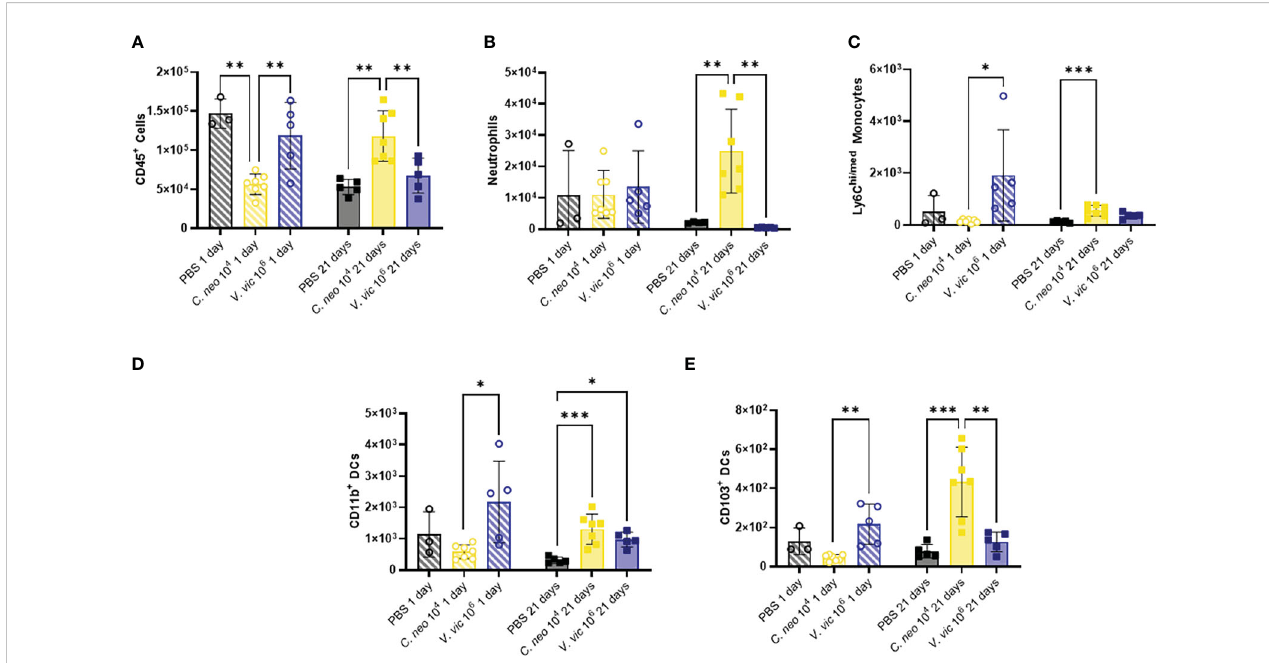
FIGURE 4 C. neoformans exposure has a stronger impact on myeloid populations in the BALF over time compared to V. victoriae . Cell quanti fi cations (numbers) in BALF following repeated exposure to PBS (black), 10 4 C. neoformans cells (yellow) or 10 6 V. victoriae cells (blue) at 1 day post fi nal exposure (circles, crossed bars, left) or 21 days post fi nal exposure (squares, solid bars, right). (A) CD45 + Cells, (B) Neutrophils, (C) Ly6C hi/med Monocytes, (D) CD11b + Dendritic Cells, and (E) CD103 + Dendritic Cells. n=3-7 per group, *P<0.05, **P < 0.01, ***P < 0.001. P values were determined by ordinary one-way ANOVA with Tukey ’ s multiple comparisons test comparing each exposure together for the same